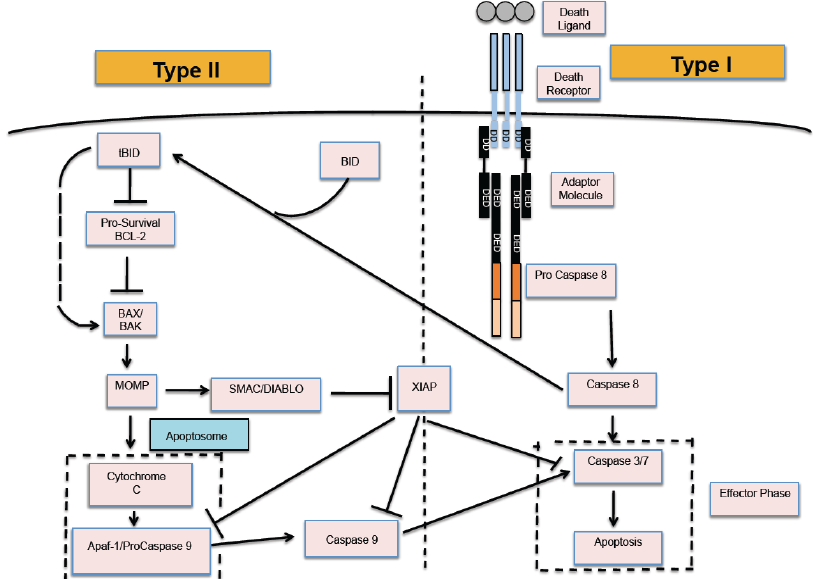
Figure 1. Schematic of the apoptotic death signaling network. Apoptosis is activated through two distinct pathways: type 1 (intrinsic) and type 2 (extrinsic). The type 1-type 2 signaling loop is initiated by generation of active caspase 8 and ultimately converges on caspase 3/7